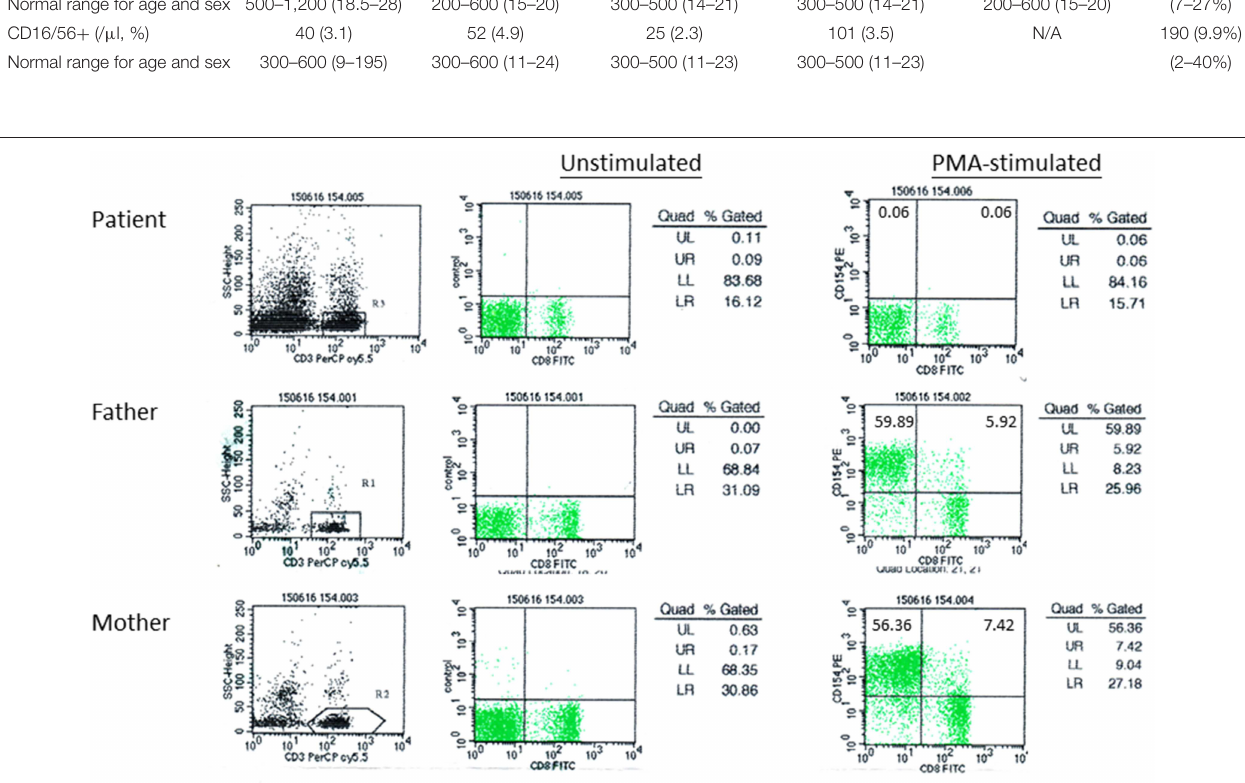
FIGURE 1 | CD40L expression in patient F1 and his parents. Peripheral blood mononuclear cells (PBMCs) were activated by phorbol myristate acetate (PMA) and ionomycin, followed by immunostaining with anti-CD3-PerCP-Cy5.5, anti-CD8-FITC, and anti-CD154-PE antibody. Flow cytometric analysis was performed gating on CD3 + T-cells. CD3 + CD8-CD154 + , represented by UL (upper left quadrant), indicated activated T-cells expressing CD40L.